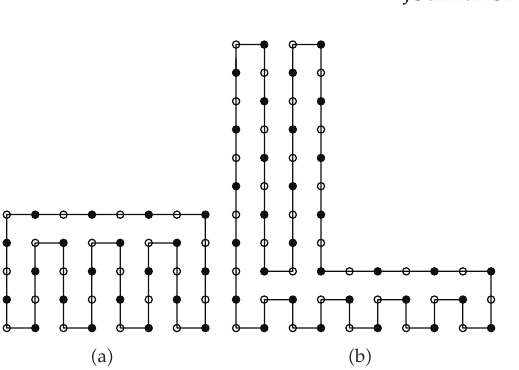
Figure 3: A Hamiltonian cycle for the rectangular grid graph R (cid:6) 8 , 5 (cid:7) and L -alphabet grid graph L (cid:6) 4 , 3 (cid:7) .